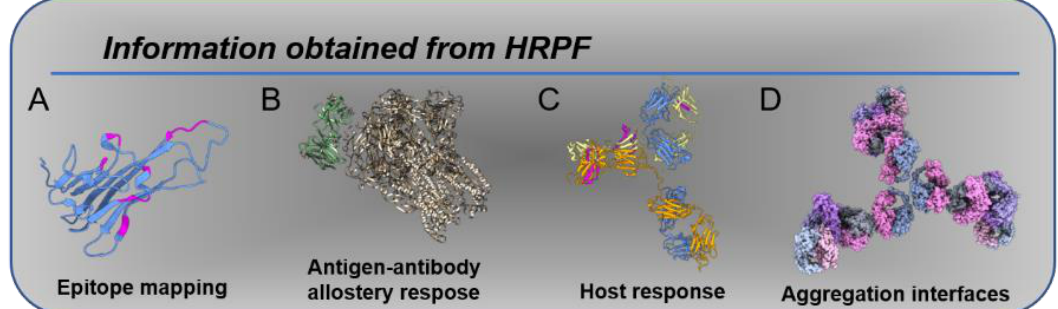
Figure 1. Information obtained from HRPF: ( A ) epitope mapping, as in [20]; ( B ) allosteric changes induced by antigen binding [24]; ( C ) host response, as in [23], in which anti-drug antibodies exhibit protection in response to therapy; ( D ) aggregation interfaces, as in [22].